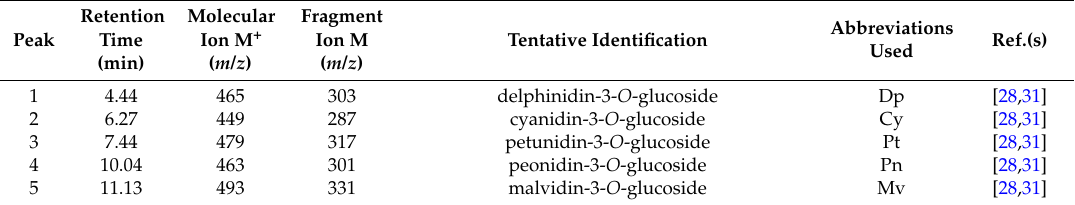
Table 2. Characterization of anthocyanin compounds in berry skins using HPLC-DAD-MS.